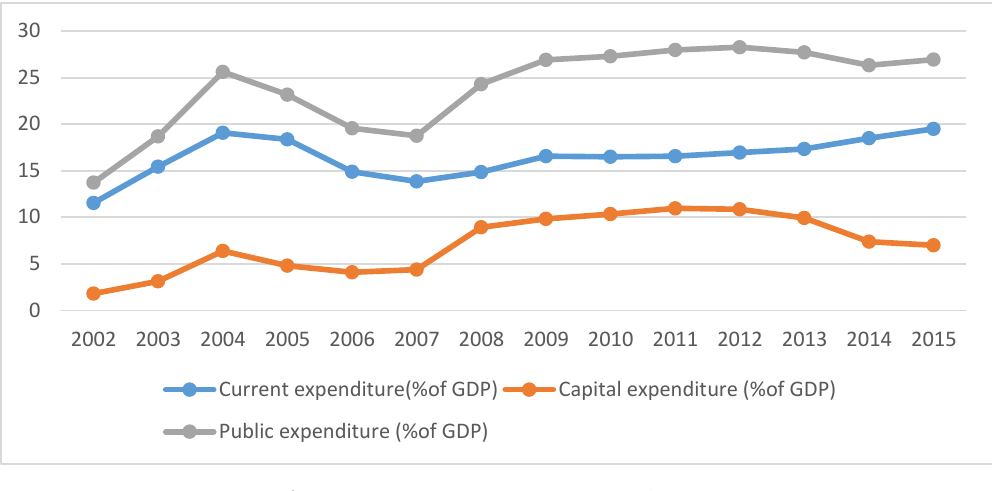
Fig. 1. Public expenditures, % GDP